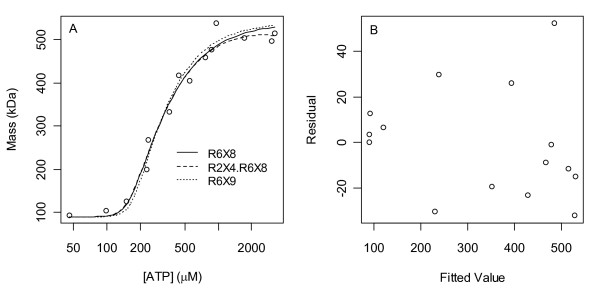
Top 3 fits to the data of Kashlan et al. [20]. A) Fits of the top 3 models. The second model uses its dimer term to capture a slight downturn in average mass at high [ATP] (see Fig. 9), consistent with its geometric mean binding constant being greater than that of the hexamer term in Table 1. Not shown in this plot is the point (0 μM, 90 kDa) which all models fit perfectly if M1 = 90 is fixed (as it is here) rather than estimated. B) Residuals of the top model R6X8. The reduced variance and positive mean of the first 4 residuals may be due to bias arising from prior knowledge that the monomer is 90 kDa and thus too prior knowledge that the average mass must increase from 90 kDa. Non-weighted least squares gives less weight to these 4 points which, coincidentally, is advantageous given these suspicions. PlotDigitizer (Methods) was used to obtain the data from a pdf of the original paper, and as this step involves human intervention, it too may have introduced some bias and random error.